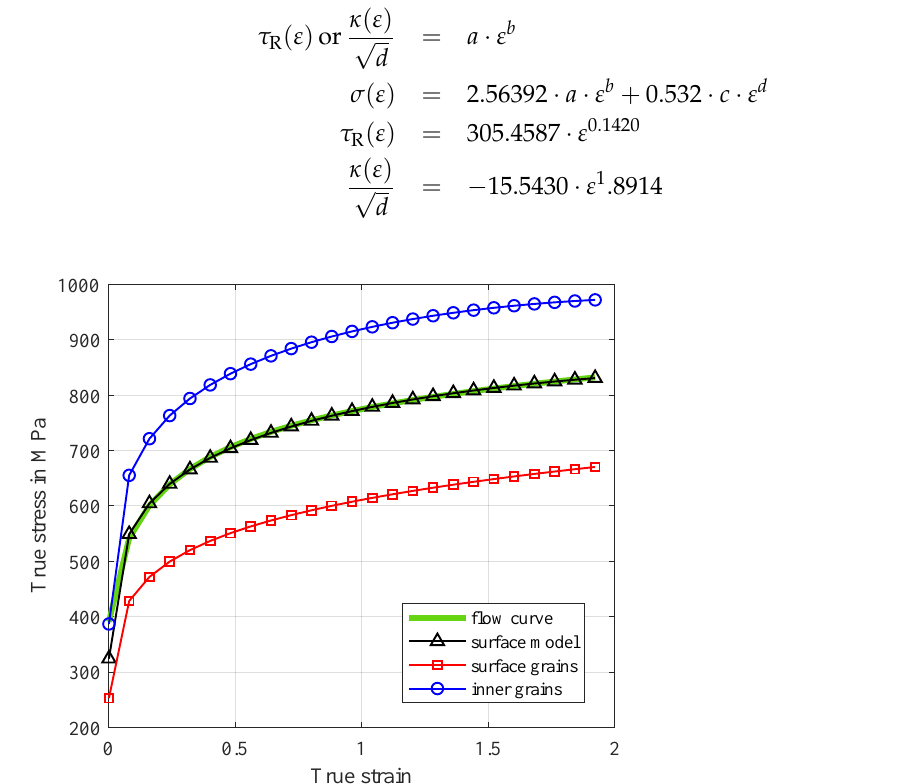
Figure 14. Separation of the extrapolated flow curve in the flow stress of surface grains and inner